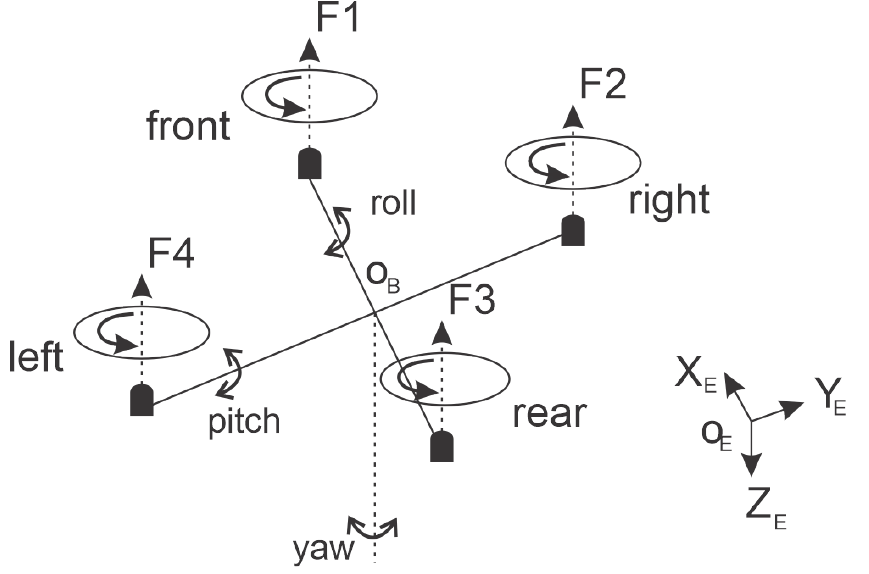
Figure 1. Quadrotor Mechanical